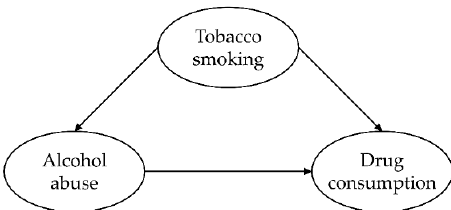
Figure 1. Conceptional model of the mediating e ff ect of alcohol abuse in the relationship between tobacco smoking and drug consumption.